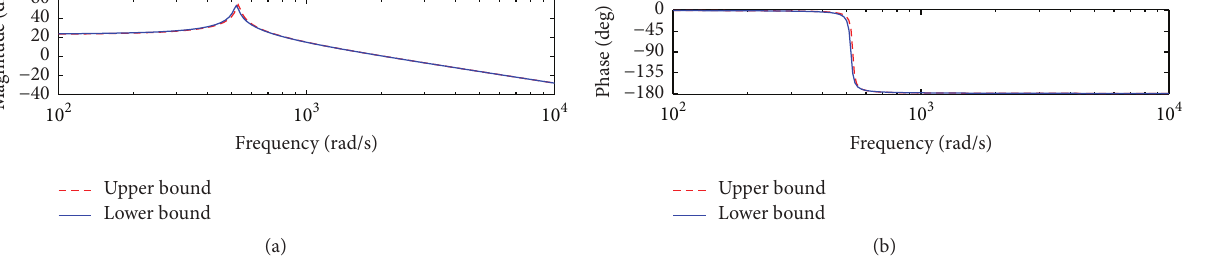
Figure 4: The frequency response of piezo actuator.